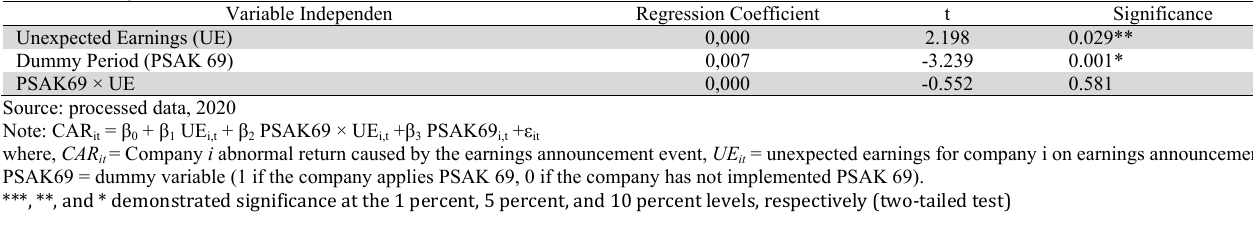
Paired Differences